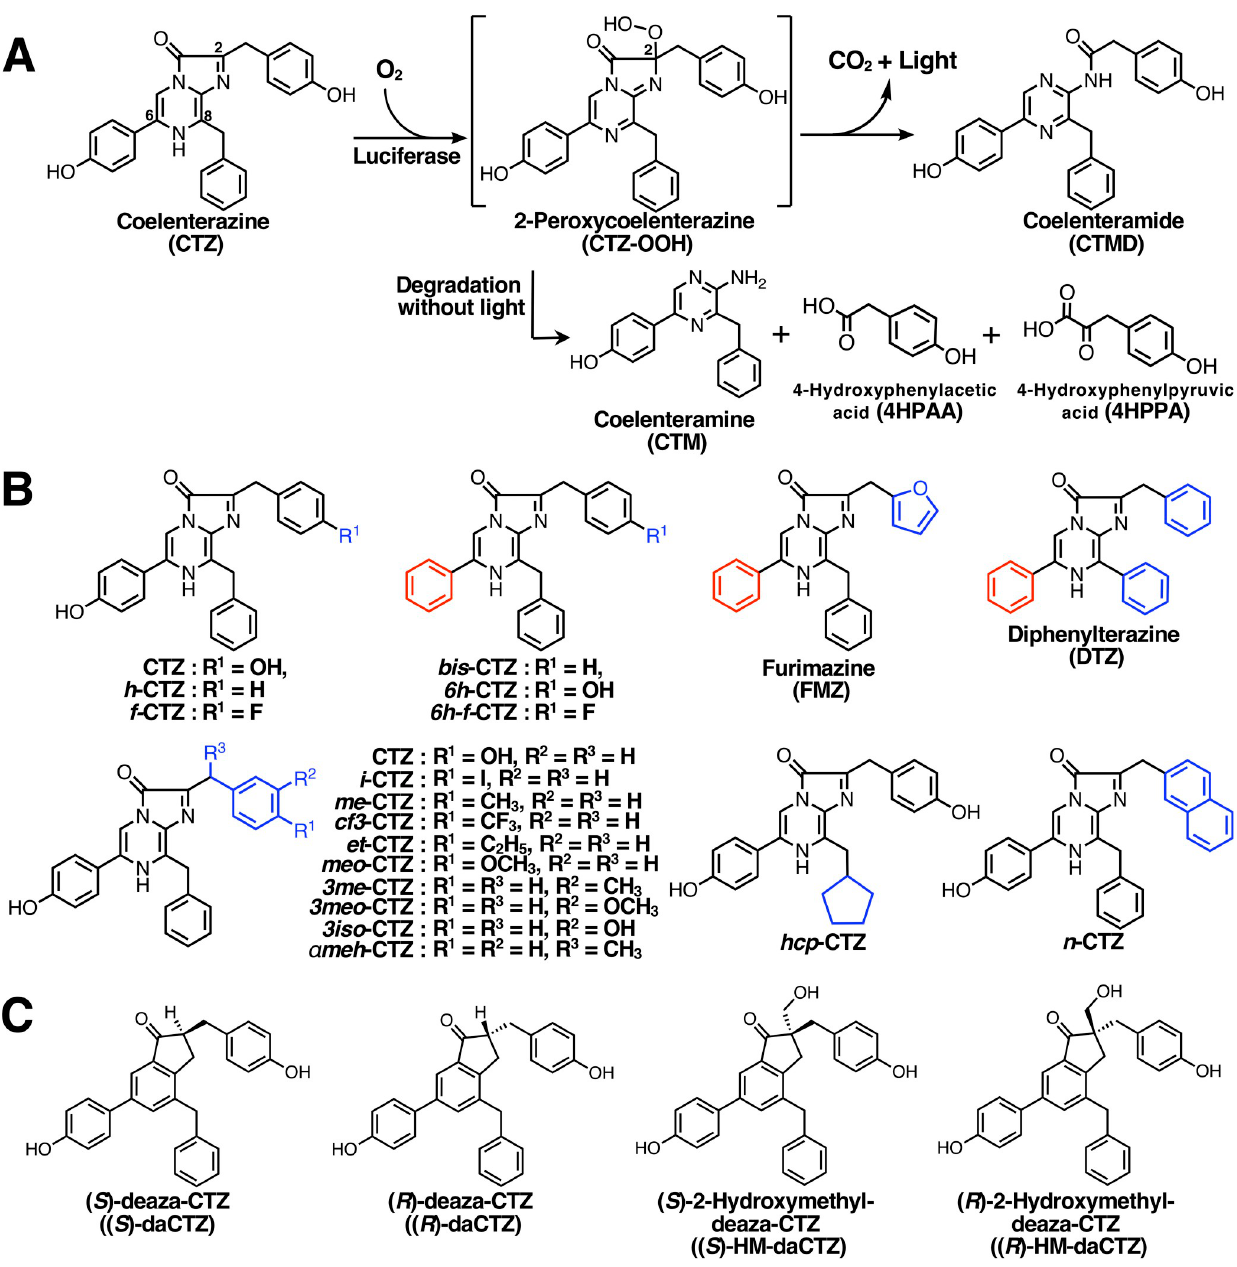
Fig 1. Luminescence reaction of coelenterazine (CTZ) catalyzed by the CTZ-utilizing luciferase and chemical structures of CTZ analogs and deaza- CTZ analogs. A. Oxidation process of CTZ with O 2 by CTZ-utilizing luciferases and the degradation product of coelenteramine (CTM), 4-hydroxyphenylacetic acid (4HPAA), and 4-hydroxyphenylpyruvic acid (4HPPA) through 2-peroxycoelenterazine (CTZ-OOH). B. Chemical structures of C2- and C6-modified CTZ analogs. The C6-group of CTZ analogs was colored in red, and the C2- and C8-groups of CTZ analogs were colored in blue. C. Chemical structures of deaza-analogs for CTZ and CTZ-OOH as